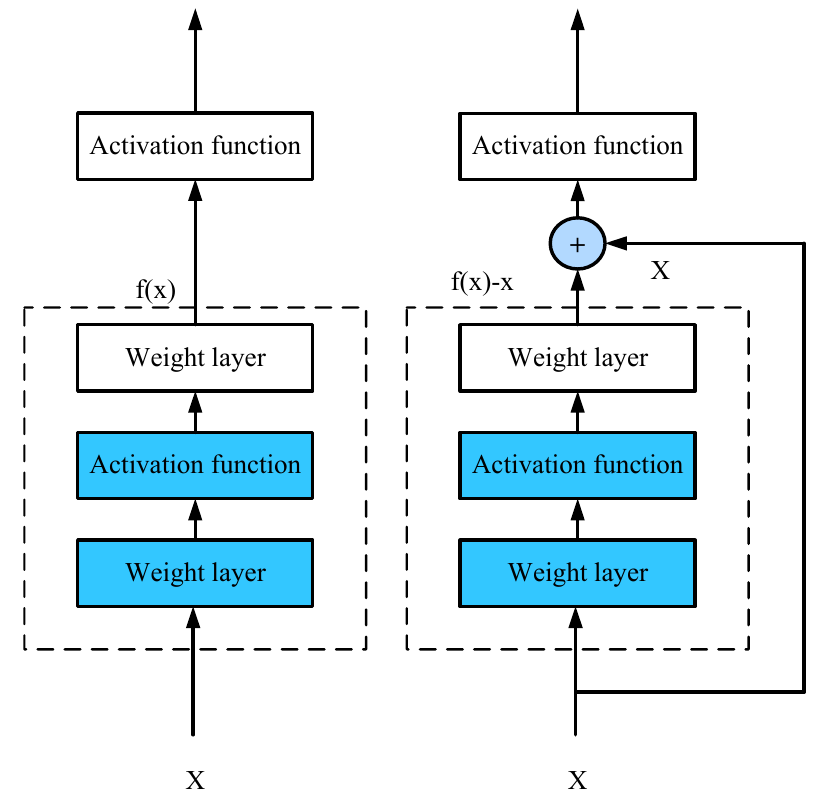
Figure 11. Residual connection structure